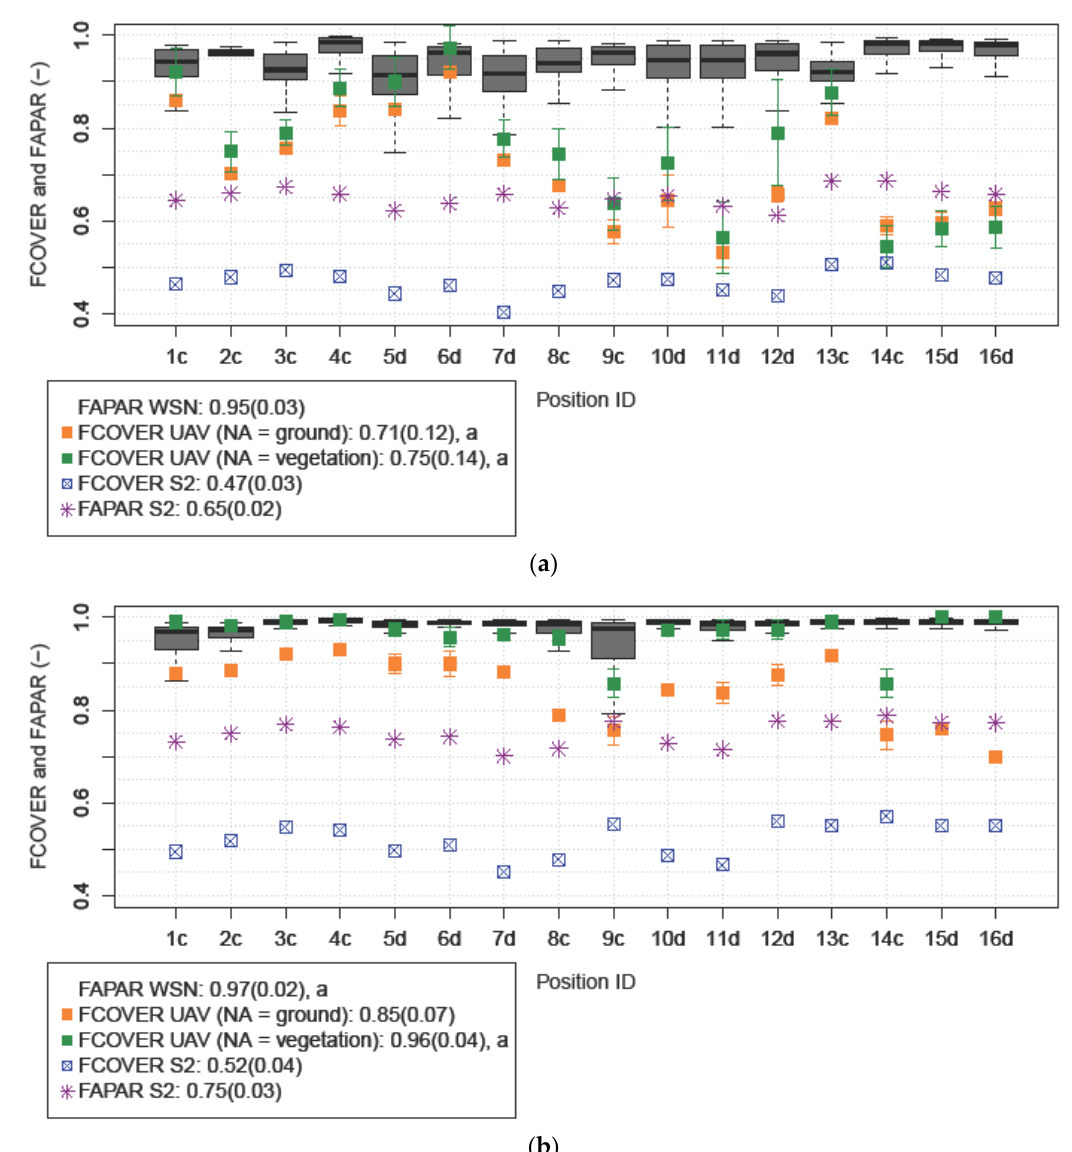
Figure 9. Boxplots of FAPAR-WSN and remote sensing products at the ( a ) spring and ( b ) summer acquisition dates. The legend shows the mean (sd) of all the obtained values; the results of the KS test are indicated with small letters ( p > 0.05). Position IDs (x-axis) of the PAR sensor locations indicate species compositions in the 10-m surroundings as follows: c = ratio of basal area of conifers ≥ 85% and d = ratio of basal area of conifers <85%.